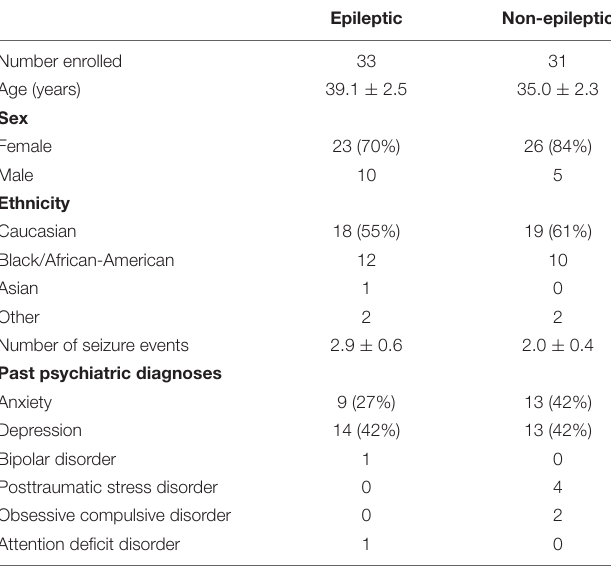
TABLE 2 | Baseline patient demographic information.